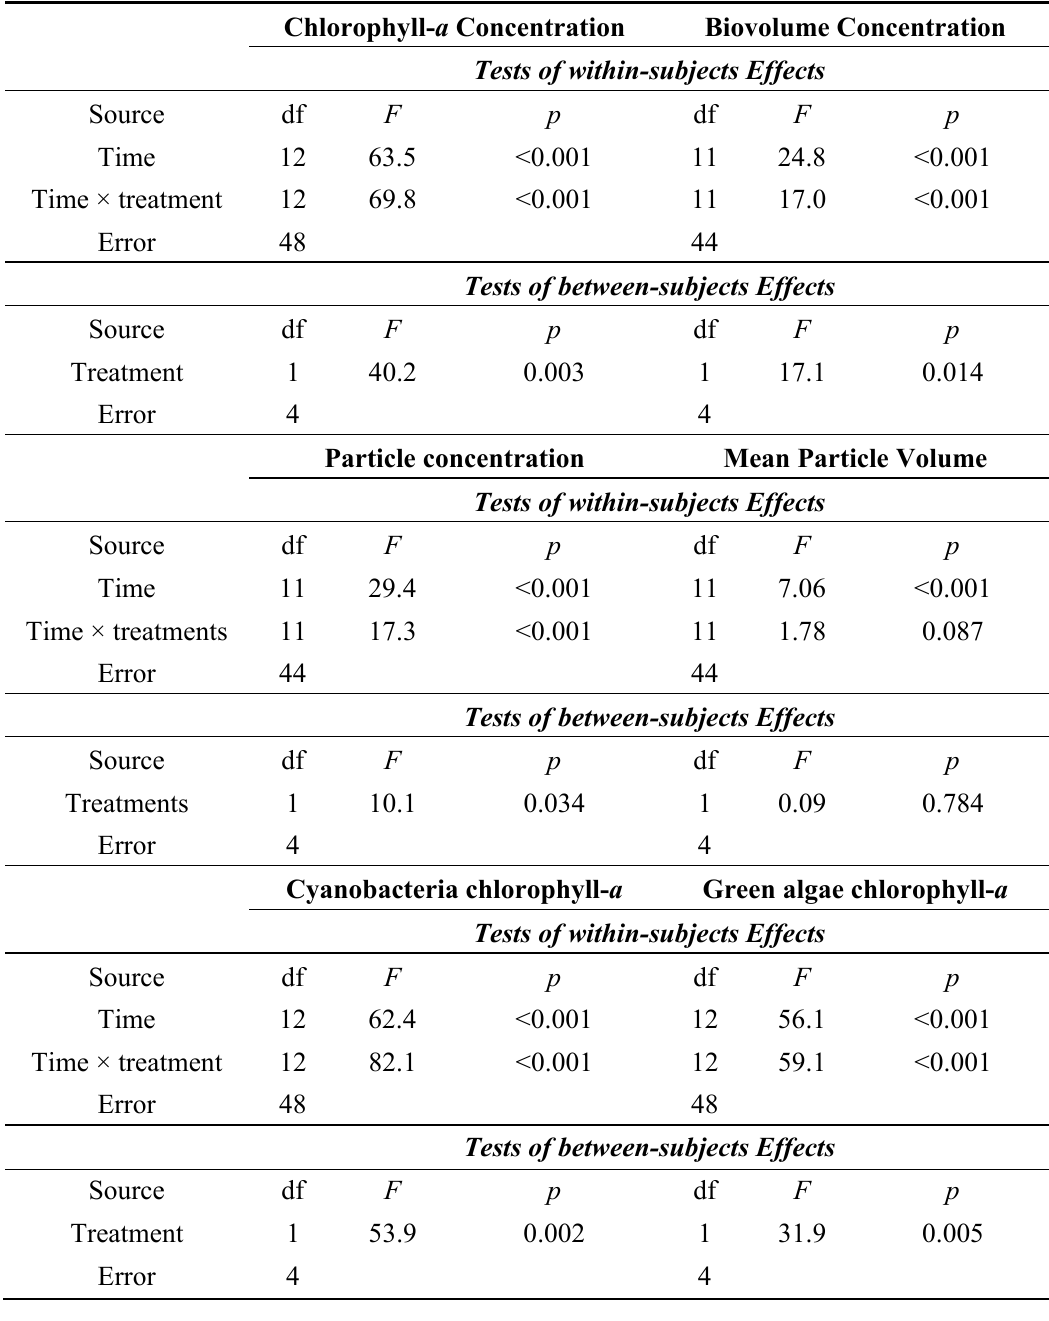
Table 2. Summary of repeated measures ANOVAs for total chlorophyll- a concentration, biovolume of phytoplankton, particle numbers, mean particle volume, cyanobacteria chlorophyll- a and green algae chlorophyll- a concentrations in 85 L tanks without and with exposure to ultrasound (treatment) as the fixed